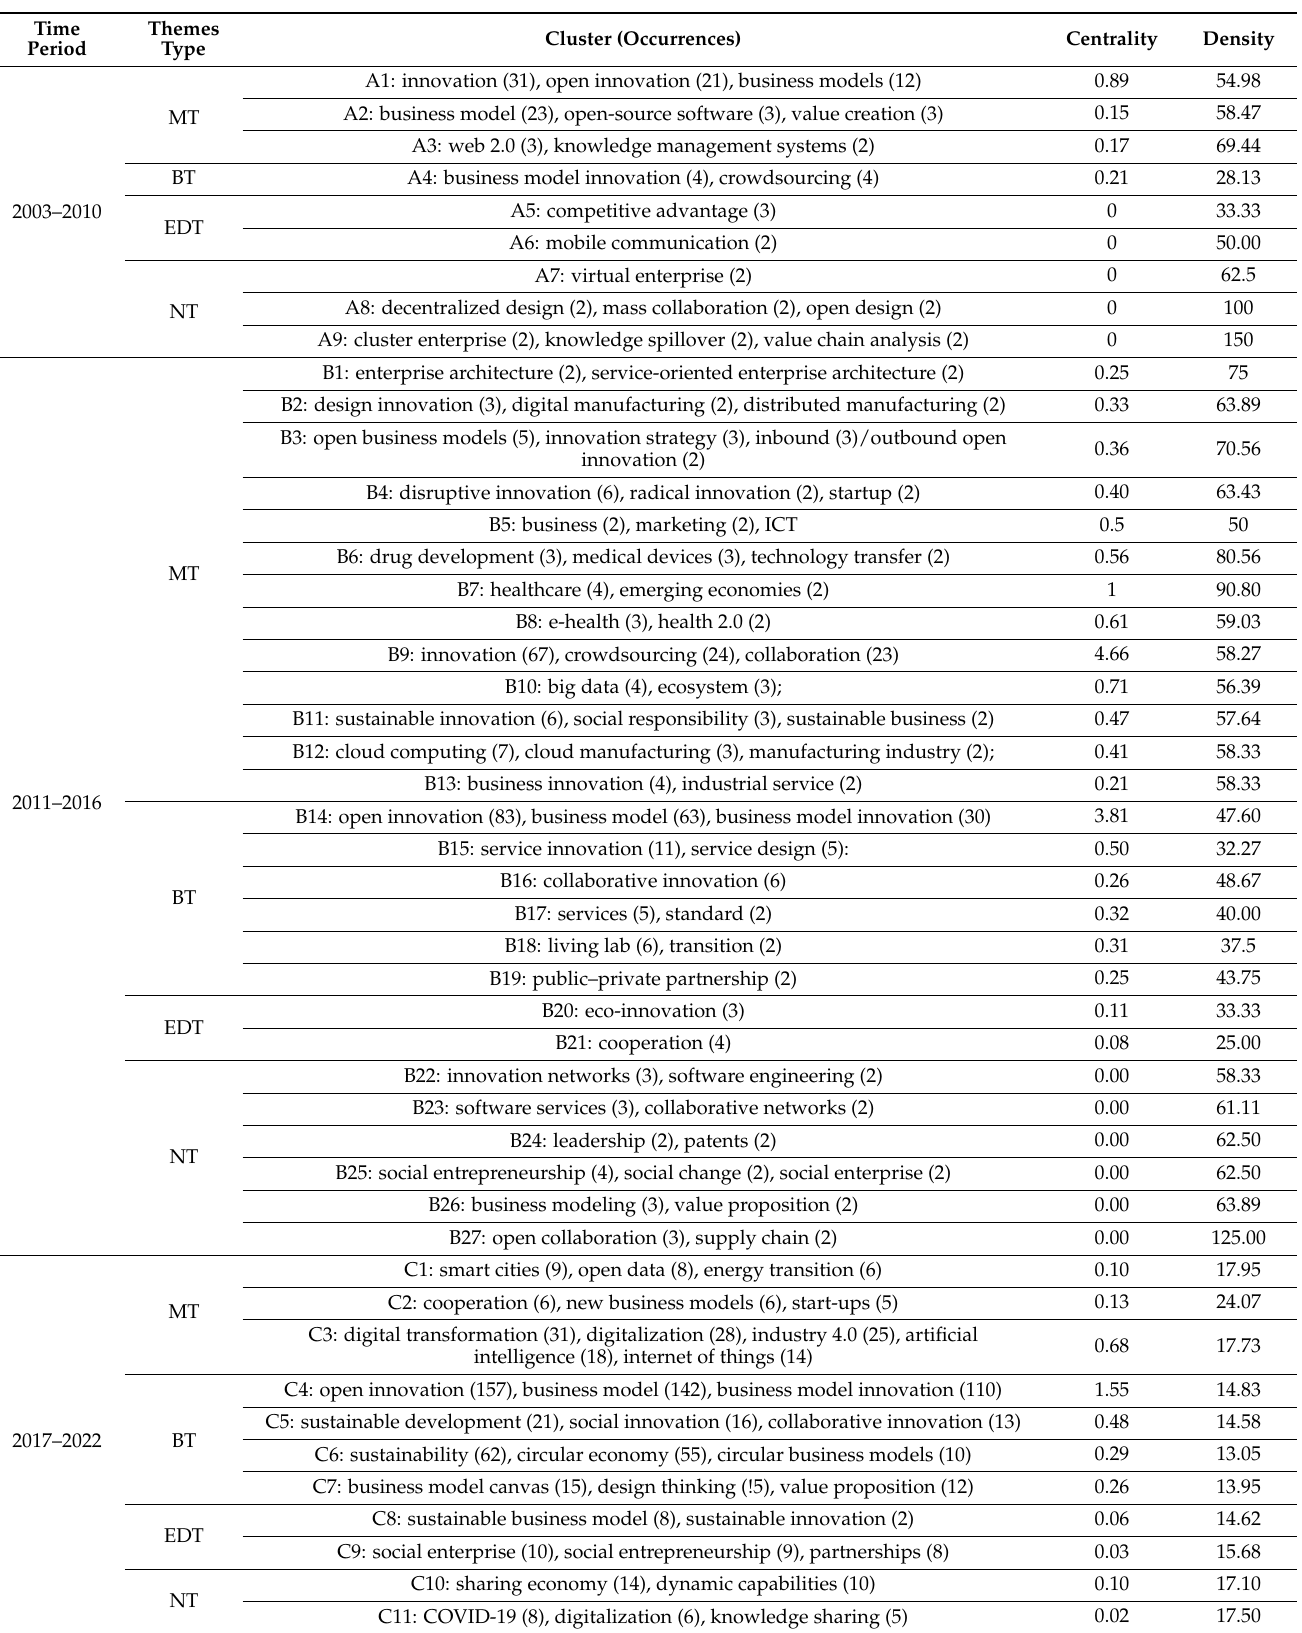
Table A2. Specific indicators for the identified thematic